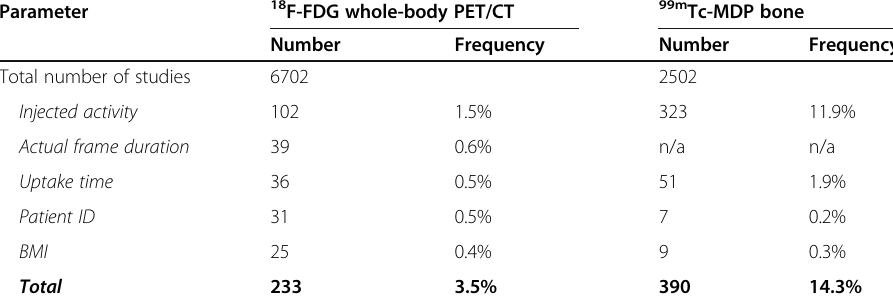
Table 1 Descriptive statistics of the errors in 18 F-FDG whole-body PET/CT and 99m Tc-MDP